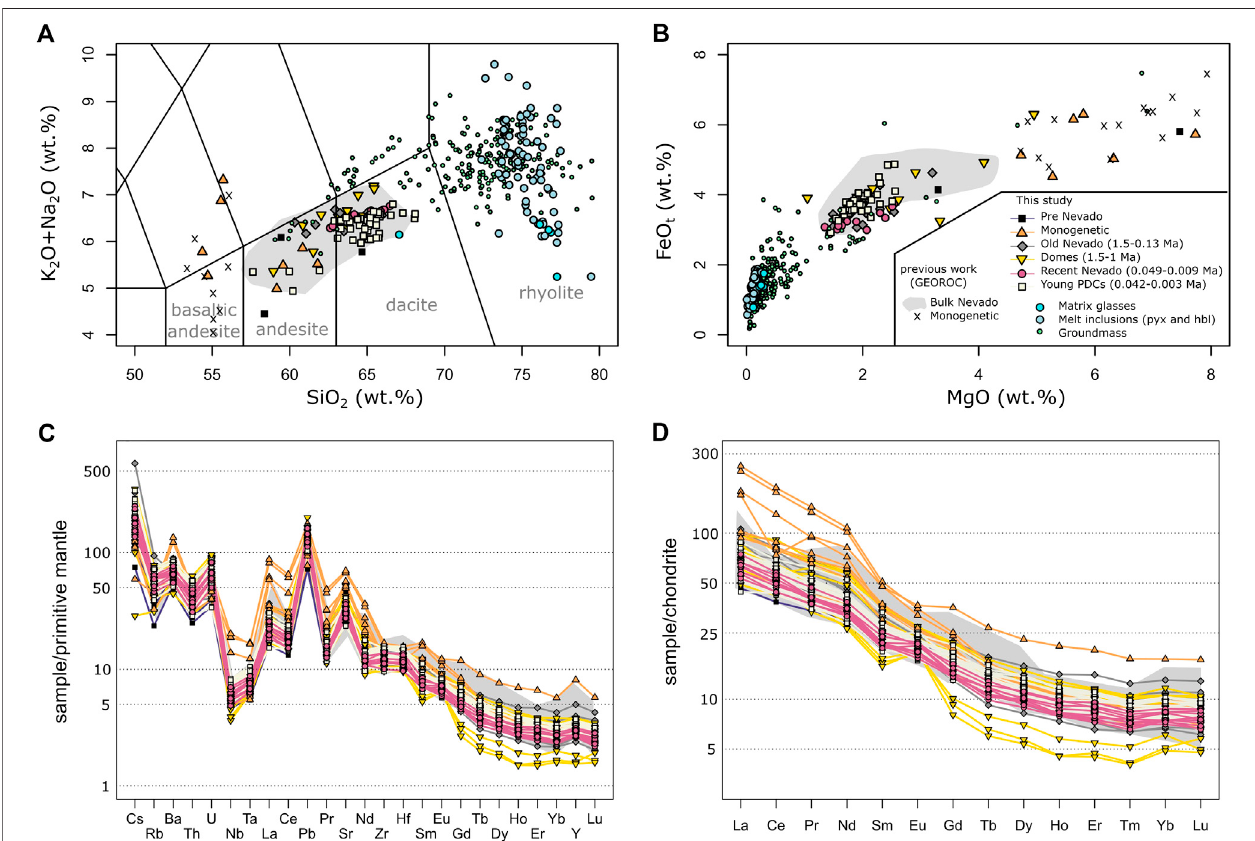
FIGURE4| Summaryofmajorand traceelementsystematicsofNevadodeTolucavolcano. (A) Totalalkalivs.silicadiagram.ShownarePre-Nevadogroup(black squares), Monogenetic cones (orange triangles), Old Nevado stage (gray rhombus), Domes (gold triangles), Recent Nevado stage (red circles), and Young Pyroclastics (beige squares). Matrix glasses and melt inclusions are plotted as turquoize and light blue circles, respectively. Crystalline groundmass measurements are indicated by smalllightgreencircles.DashedcircleindicatessampleswithelevatedK 2 Ocontentscorrespondingtoalkalinecones.Grayshadedareaandblackcrossesindicate previous work (GEOROC database: http://georoc.mpch-mainz.gwdg.de/georoc). (B) Bivariate plot of FeO t and MgO (wt%). (C) Primitive mantle normalized trace element variation diagram (Sun and McDonough, 1989). (D) Chondrite normalized Rare Earth Elements (McDonough and Sun, 1995).